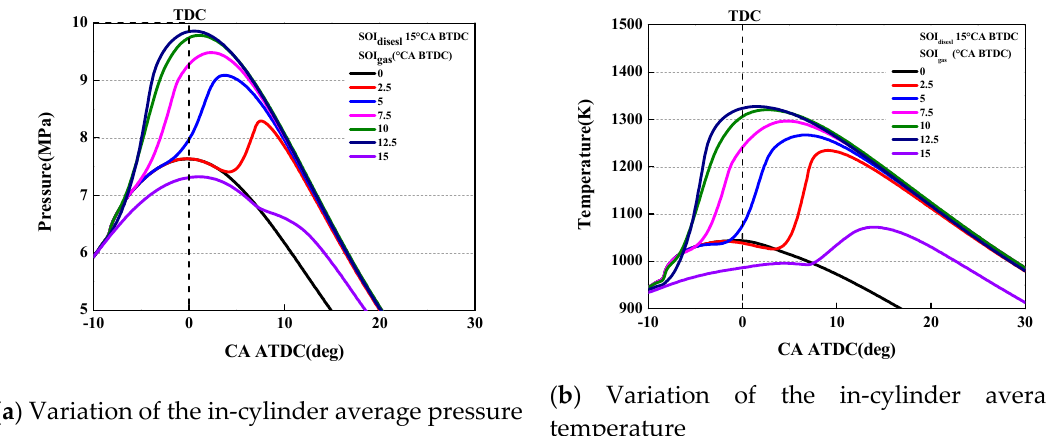
Figure 6. Variation of in-cylinder average pressure ( a ) and temperature ( b ) with NG injection timing.